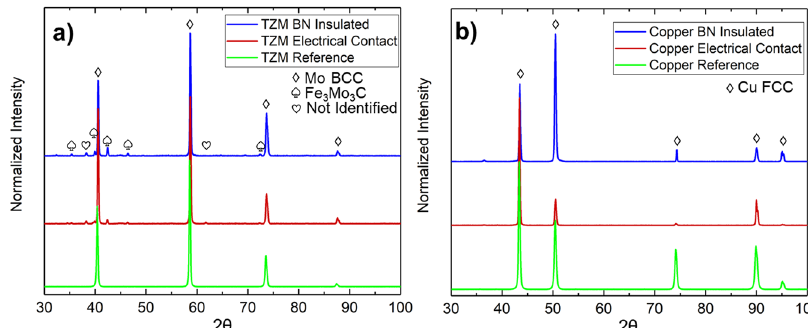
Fig. 3 XRD analysis on the TZM and copper sample sets. a TZM. b